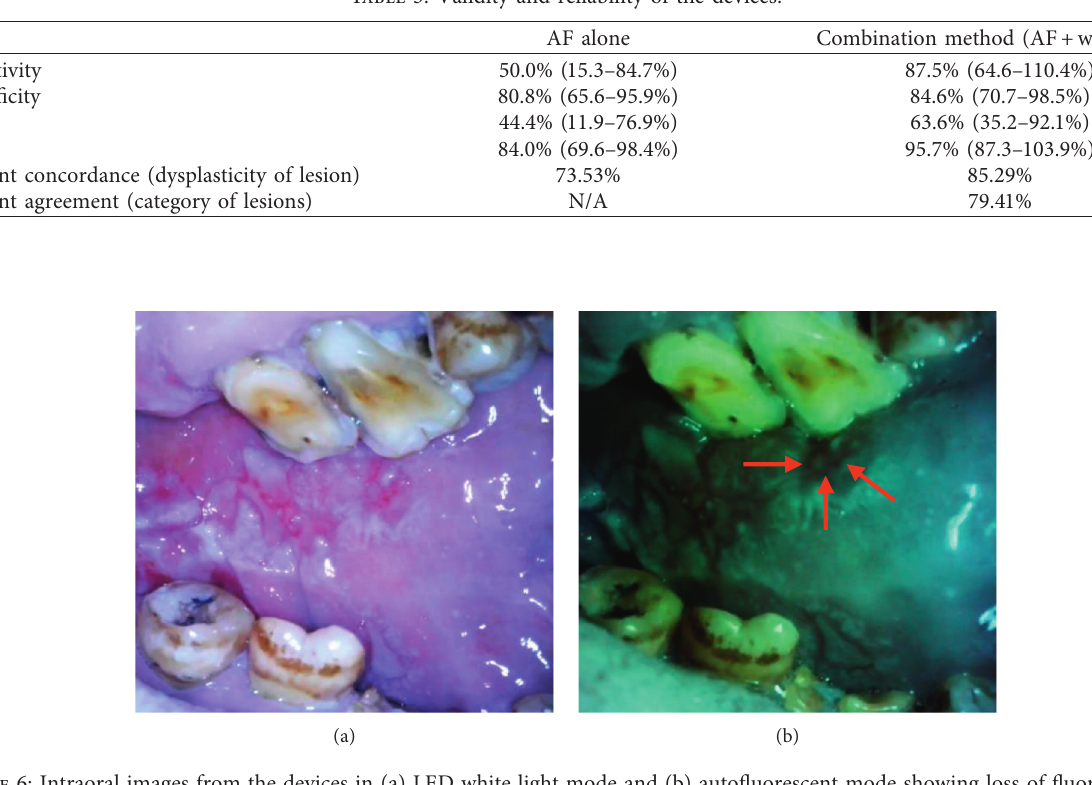
Figure 6: Intraoral images from the devices in (a) LED white light mode and (b) autofluorescent mode showing loss of fluorescence in suspicious dysplastic area.